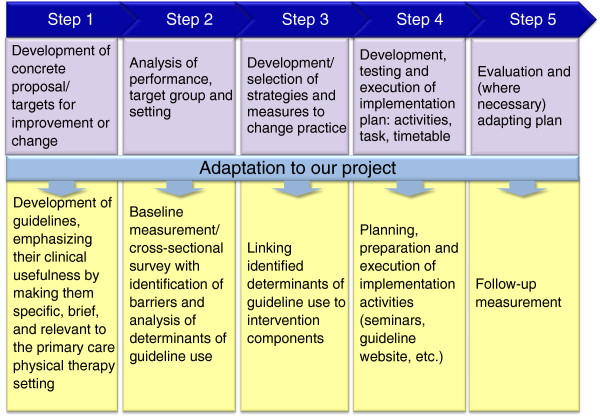
Adaptation of Grol’s et al. 5-step model for planning and executing an implementation process[17].